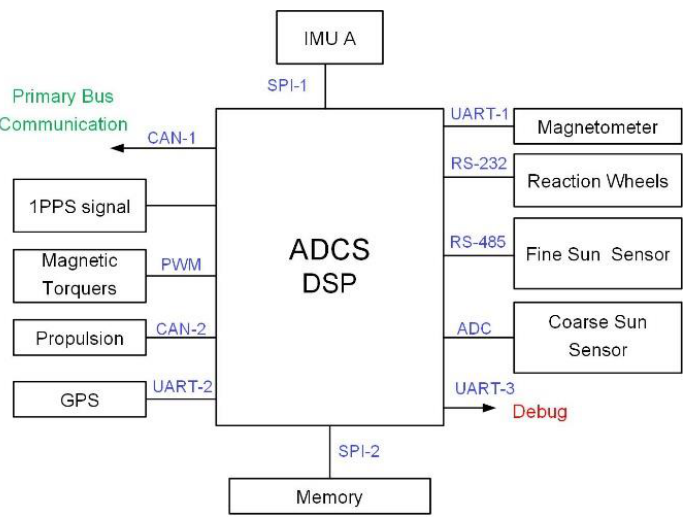
Figure 1. Input and output of attitude determination and control system’s digital signal processor.